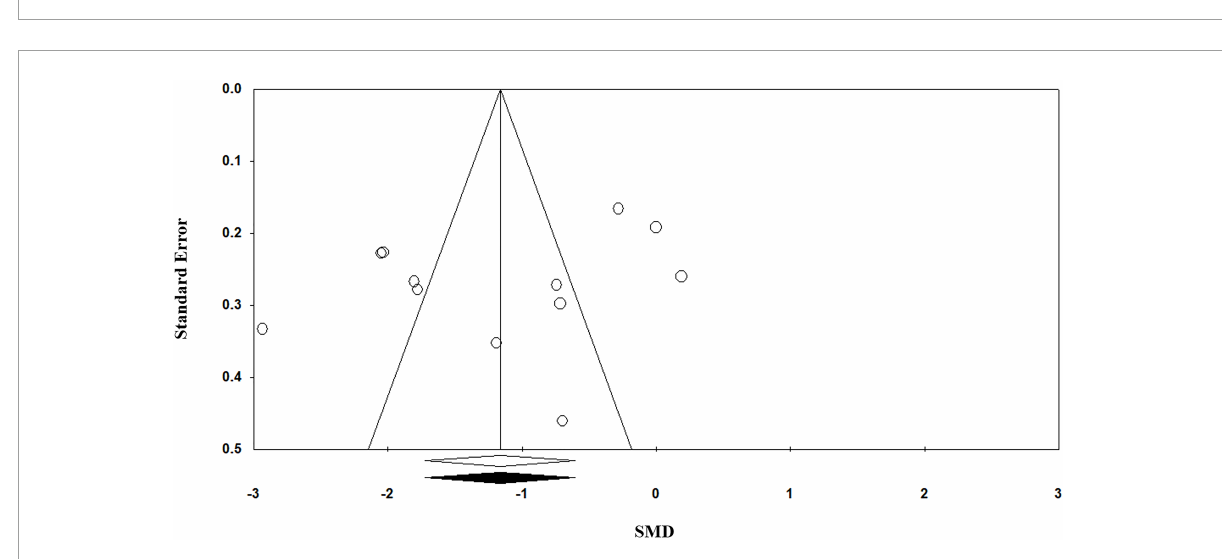
FIGURE4 Funnel plot for the meta-analysis regarding the association between vitamin C deficiency and Alzheimer’s disease